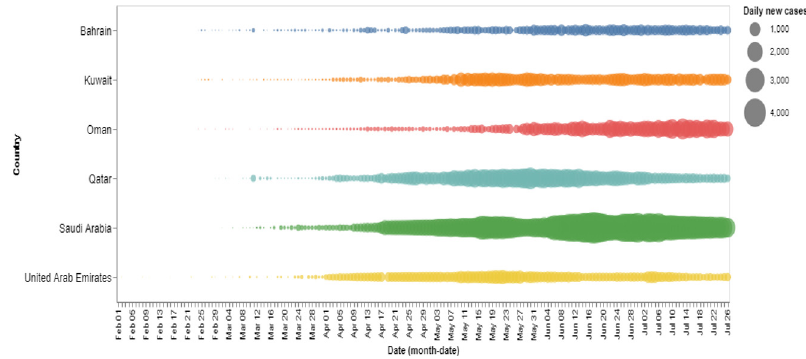
Figure 2. Daily progression